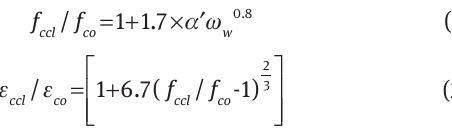
Figure 9 WG3 specimens: (A) normalized axial stress versus volu- metric strain, (B) normalized strain versus volumetric strain.